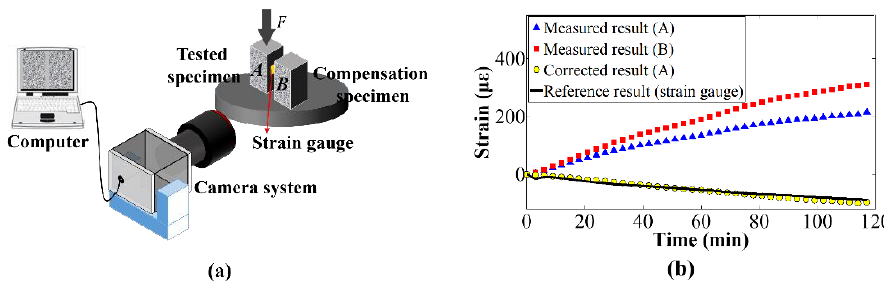
Figure 16. Experimental verification of the compensation specimen method for compensating the strain measurement error: ( a ) experimental arrangement, and ( b ) experimental results.